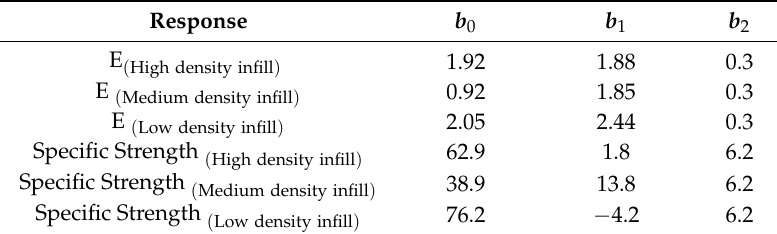
Table 5. Response surface coefficients